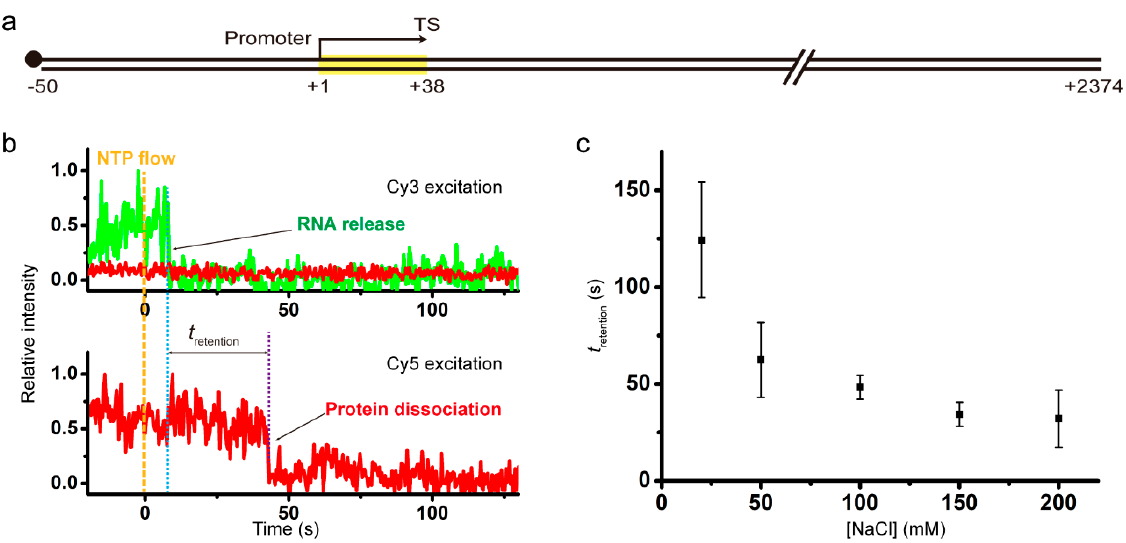
Figure 1. ( a ) A 2424-bp DNA template including a 38-bp transcription unit (yellow box) under T7A1 promoter, ending at the major termination site (TS) of tR2 terminator. The DNA is labeled with biotin (black dot) at the upstream end for immobilization. ( b ) Representative fluorescence traces. RNAP retention time, t retention , refers to the time difference between Cy3 vanishing due to RNA release and Cy5 vanishing due to RNAP dissociation in the termination cases with sequential dissociation of RNA and RNAP from DNA. ( c ) The RNAP retention times plotted against NaCl concentrations. After intrinsic termination, recycling RNAP falls off DNA sooner at higher NaCl concentrations.